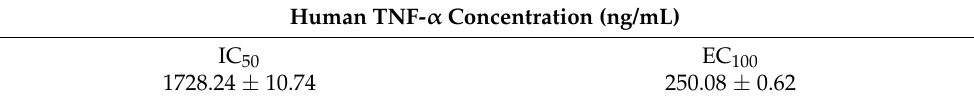
Table 11. Cytotoxicity of cell-free synthesized human TNF-α on human cancer cell lines. Human TNF-α